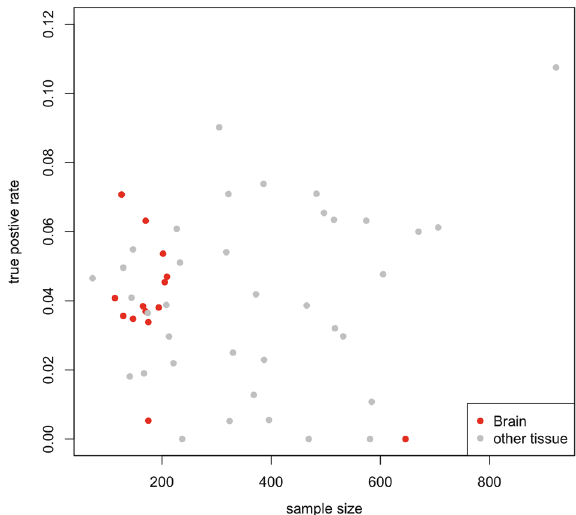
Fig. 4 Scatter plot of sample size used for model building against the true positive rate. X-axis represents the number of subjects used in PrediXcan model building and Y-axis represents the true positive rate for each model in our analysis. Color represents tissue source (red for brain tissues and gray for other tissues).